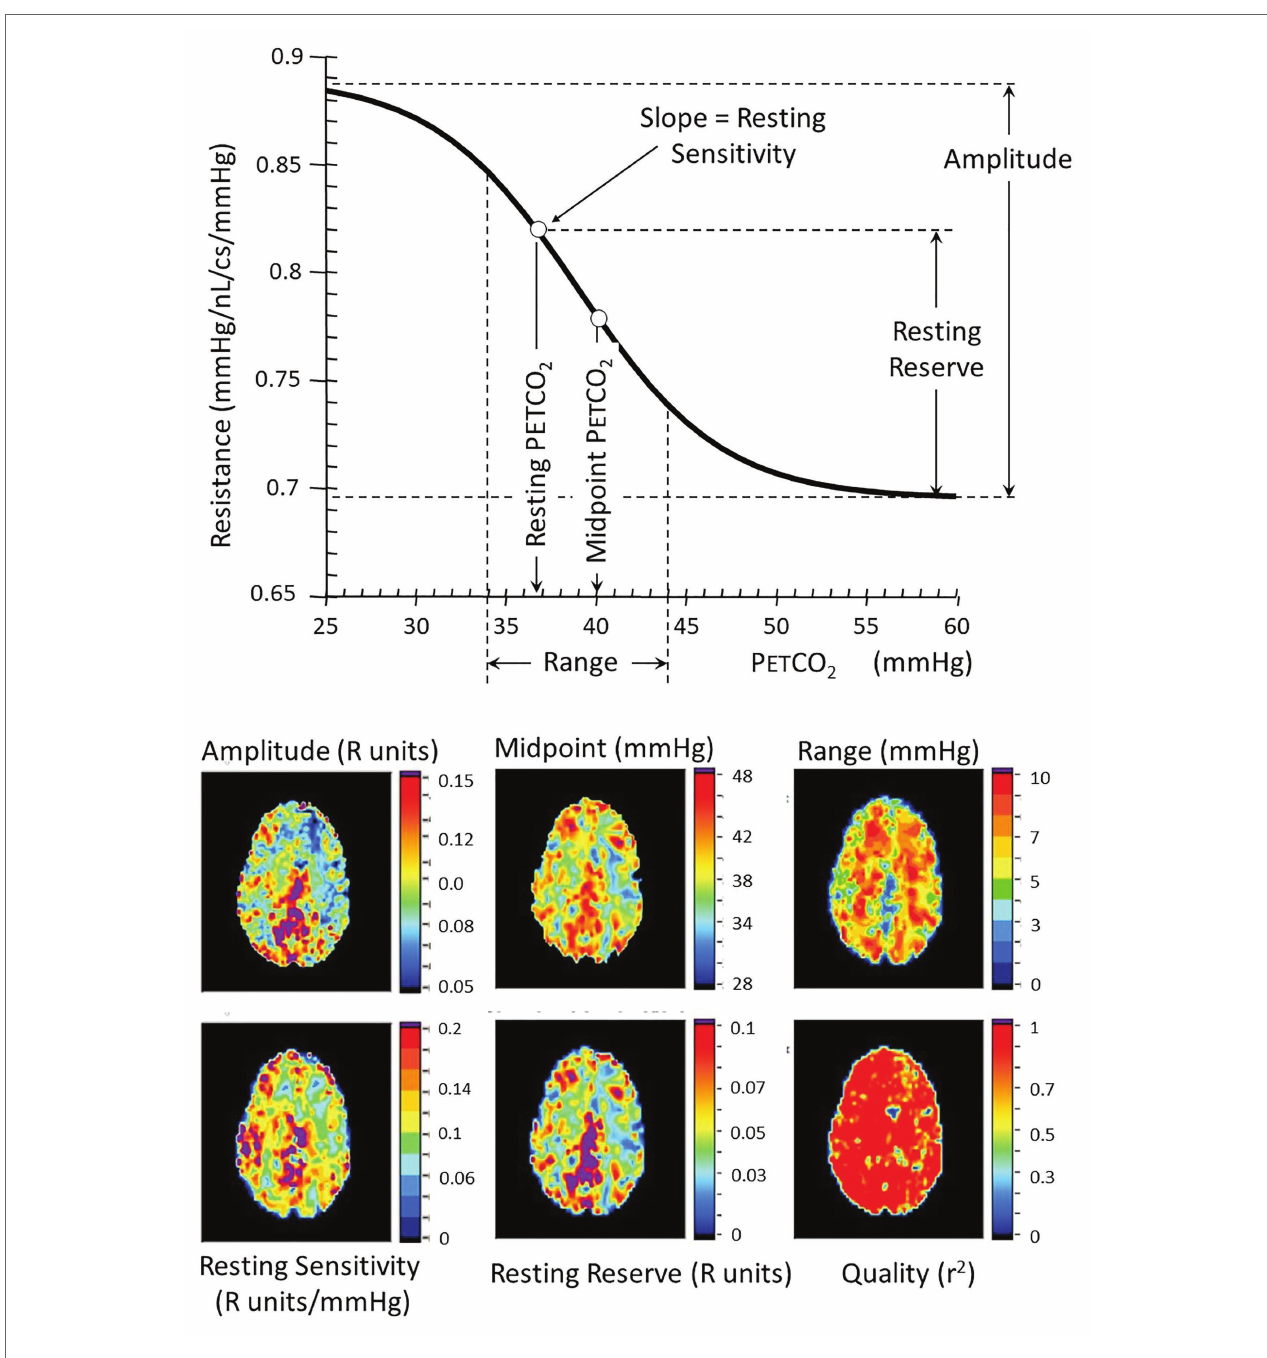
FIGURE 6 | Resistance sigmoid measures (top) and their corresponding anatomical maps (bottom) . The vascular model is that described in Figure 5 . Various aspects of the resistance-PETCO 2 relationship are expressed in the sigmoidal shape of the relationship. The graph shows some of these parameters diagrammatically, and the maps show their anatomical distribution. The amplitude shows the full extent of the vasodilation and vasoconstriction. The midpoint of the sigmoid is the PETCO 2 at its steepest slope, and the range is the span of PETCO 2 over which the response can be considered linear. The reserve and sensitivity show the vasodilatory reserve available from the subject’s resting baseline PETCO 2 and the response sensitivity (sigmoid slope) at resting PETCO 2 . The quality map shows the r 2 fit of the examined voxel resistance